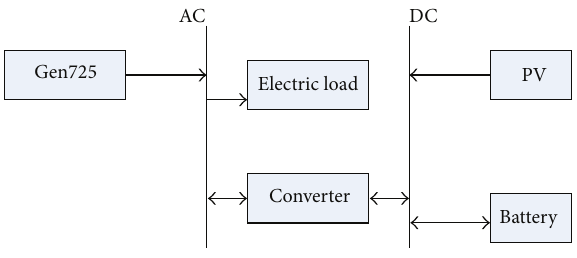
Figure 3: Hybrid renewable energy system architectural design